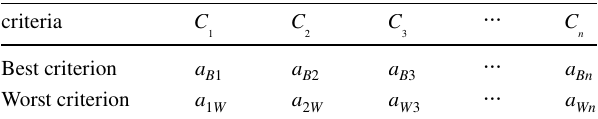
Table 2 Pairwise comparison vector for BOV and